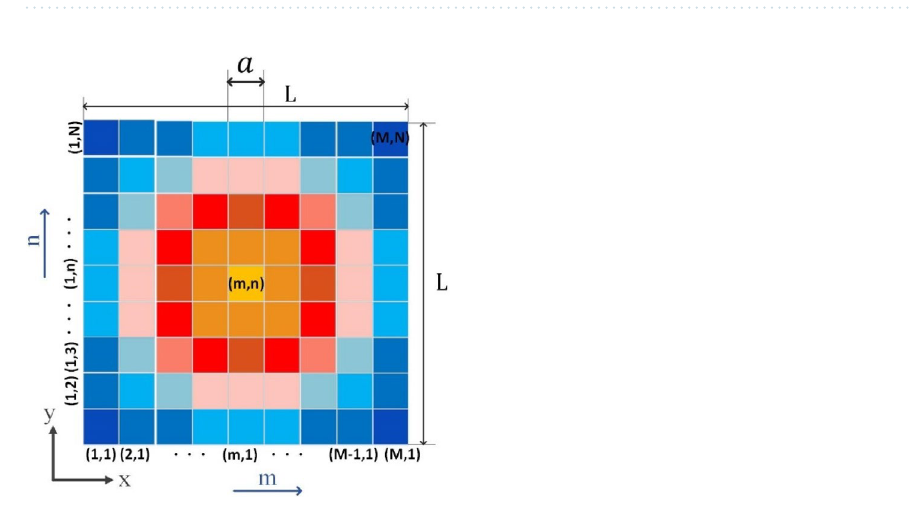
Figure 1. A structure composed of cell-clusters, each one consists of equivalent unit-cells shown with different colors.